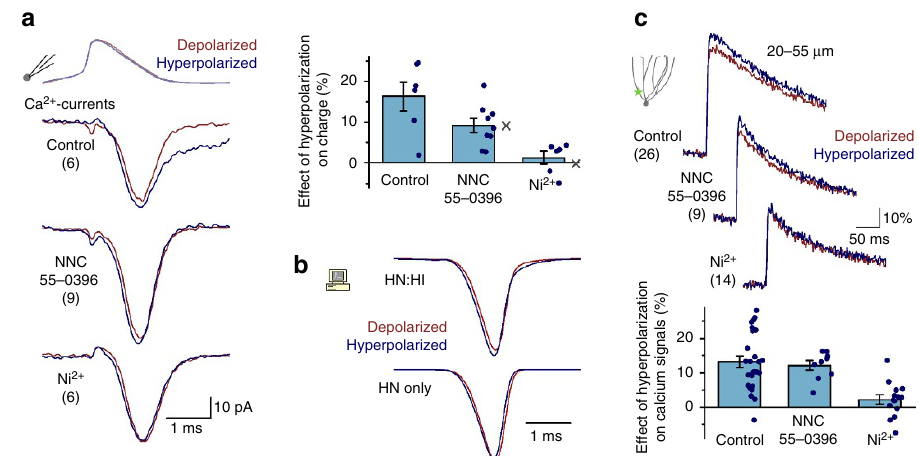
Figure 5 | Hyperpolarization-induced enhancement of calcium influx requires inactivating HVA calcium currents. ( a ) Average traces and changes in charge (0.35–1.35ms after the peak of bAP) of the calcium currents in nucleated patches evoked by previously recorded proximal bAP pairs (24 m m) at two membrane potentials, in control conditions and in the presence of Cav3 blocker, NNC55-0396 (10 m M), or in the presence of Cav2.3 and Cav3 blocker, Ni 2 þ (500 m M). Crosses indicate the changes predicted by simulations (see b ). ( b ) Simulated HVA calcium currents with inactivating and non-inactivating HVA or only non-inactivating HVA components corresponding to pharmacologically isolated currents in NNC55-0396 or Ni 2 þ , respectively. ( c ) Average calcium imaging traces at two membrane potentials and the effect of somatic hyperpolarization in control conditions and during the blockade of Cav3 (10 m M NNC55-0396), or Cav2.3 and Cav3 channels (50 m M Ni 2 þ , the lower concentration was needed to avoid interference with imaging). Numbers indicate numbers of